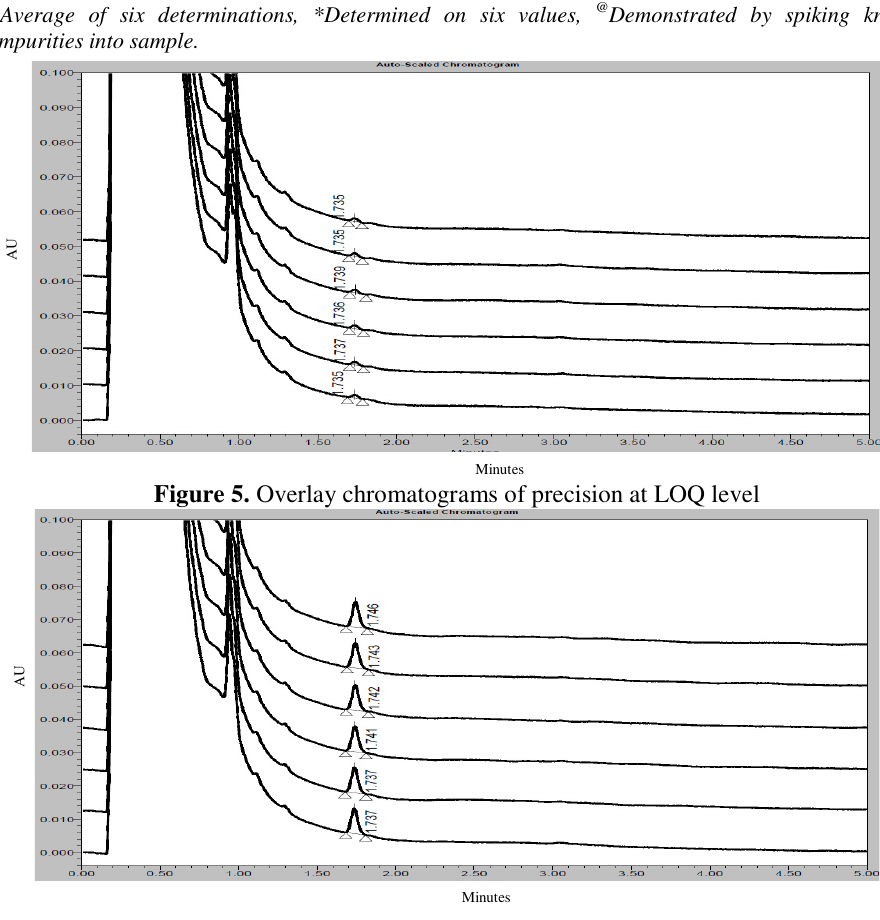
Figure 6. Overlay chromatograms of precision at 100%